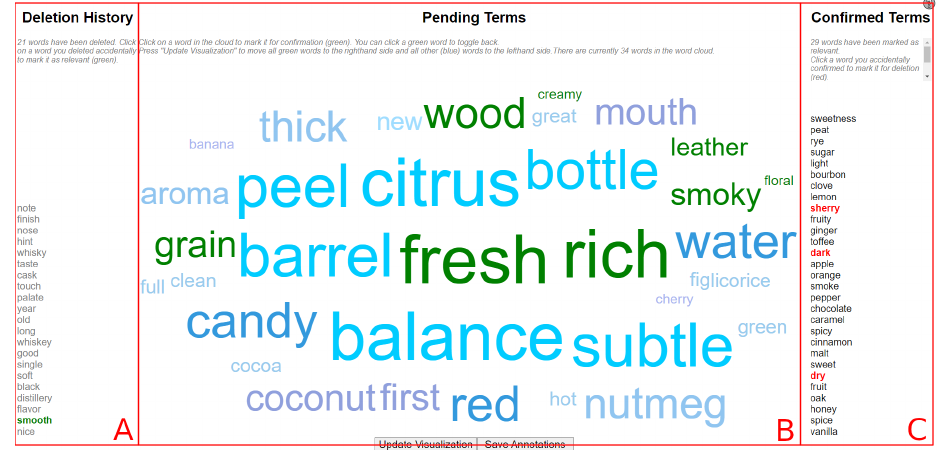
Figure 1. Interface for the Interactive Tagging Tool: ( A ) Non-descriptors (negative examples) are kept in the deletion history. ( B ) Then the most frequent words (up to 50) are shown in a word cloud format. ( C ) Confirmed descriptors (ones that are selected by the human operator) are stored in a confirmed terms